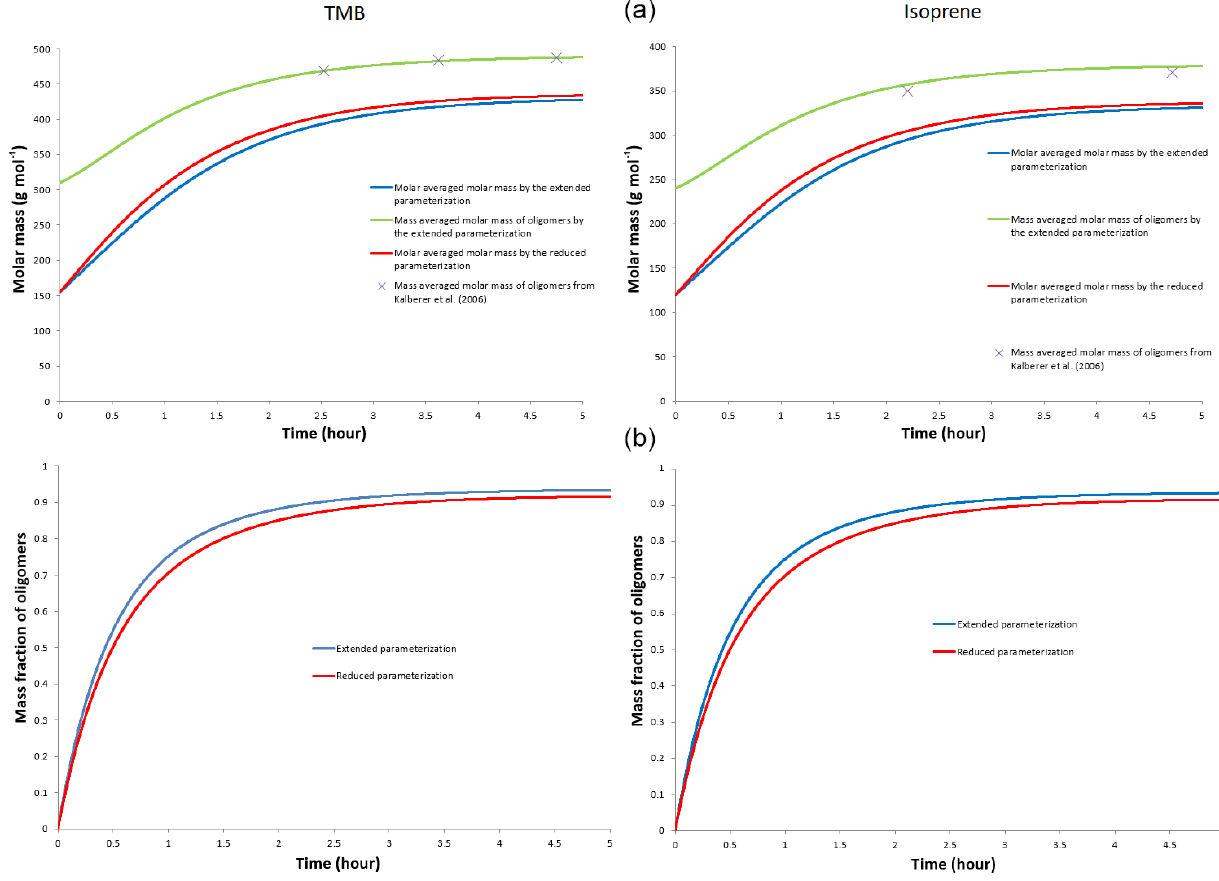
Figure 1. Temporal evolution of molar masses (a) and of the mass fraction of oligomer (b) for the extended (Eq. 1) and reduced (Eq. 3)